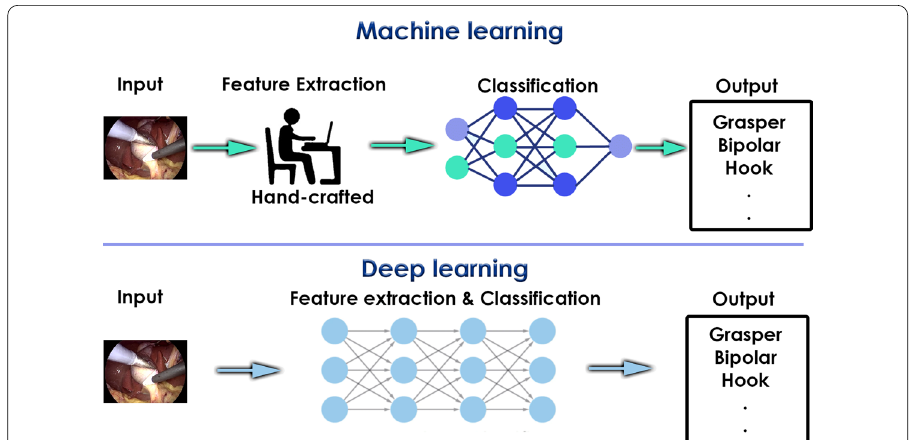
Fig. 2 Difference between machine learning and deep